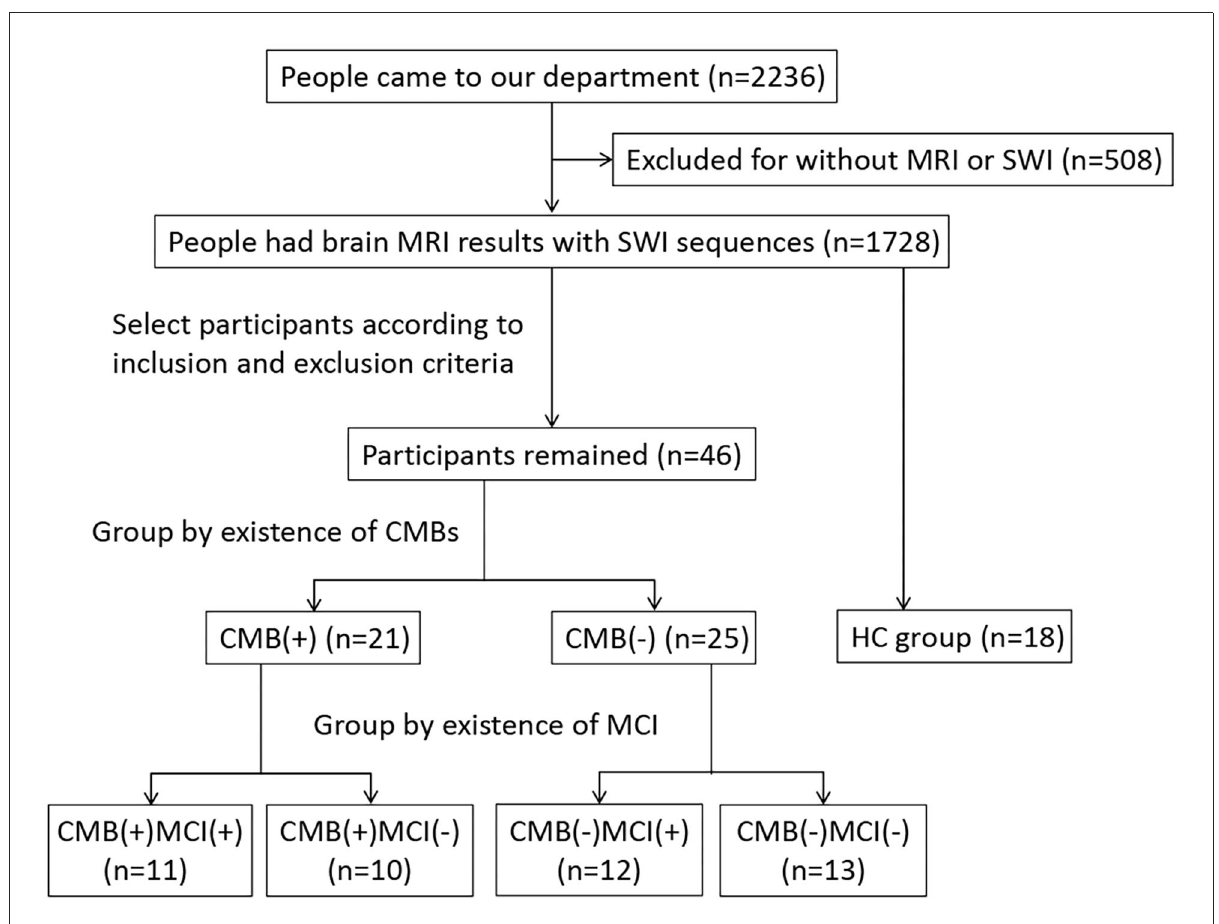
FIGURE1 Flowchart of study